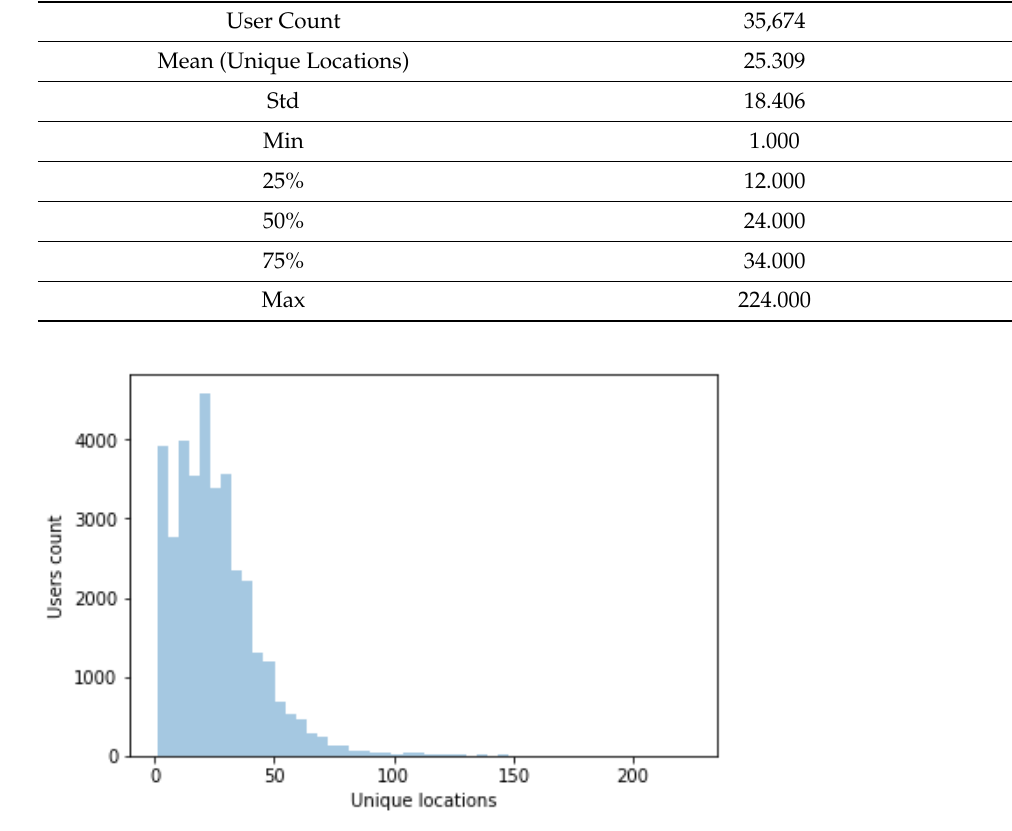
Figure 2. Histogram of unique locations per